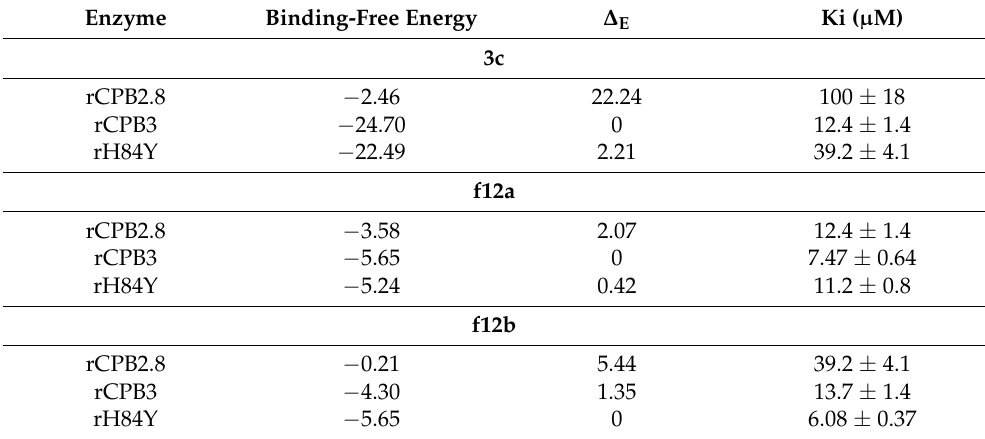
Table 5. Calculated energy values for the interaction of 3c, f12a , and f12b with the tested rCPB isoforms a .